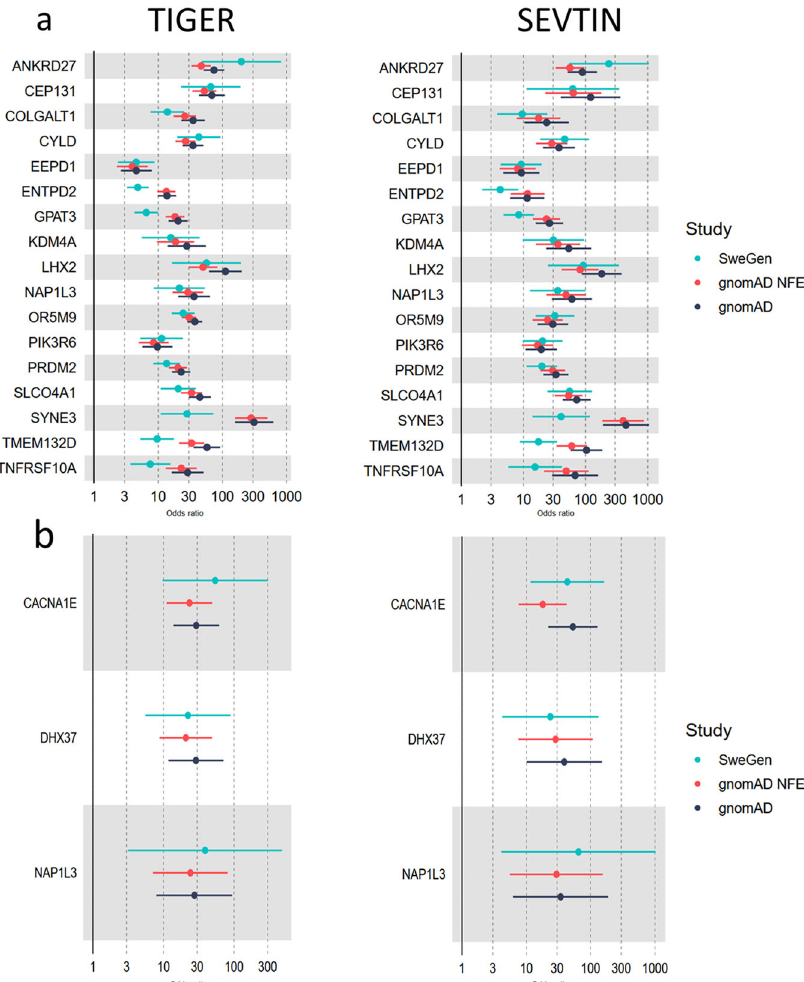
Fig. 1 Odds ratios for loss of function (LoF) and missense variants found in enriched genes in patients with tinnitus. a Genes with a burden of LoF variants in TIGER (left) and SEVTIN (right) cohorts; b genes with a burden of missense variants in TIGER (left) and SEVTIN